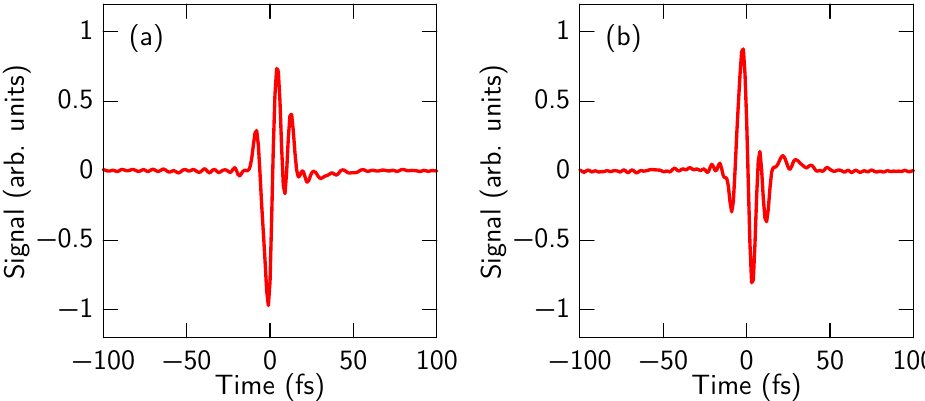
Figure 2. ( a ) A typical electric field of the sub-cycle mid-infrared pulse measured by the use of Figure 2. (a) A typical electric field of the sub-cycle MIR pulse measured by the use of FROG-CEP. (b) frequency-resolved optical gating capable of carrier-envelope phase determination; ( b ) When the delay When the delay between the fundamental and second harmonic pulses is changed by between the fundamental and second harmonic pulses is changed by phase of the field changes by π . changes by π